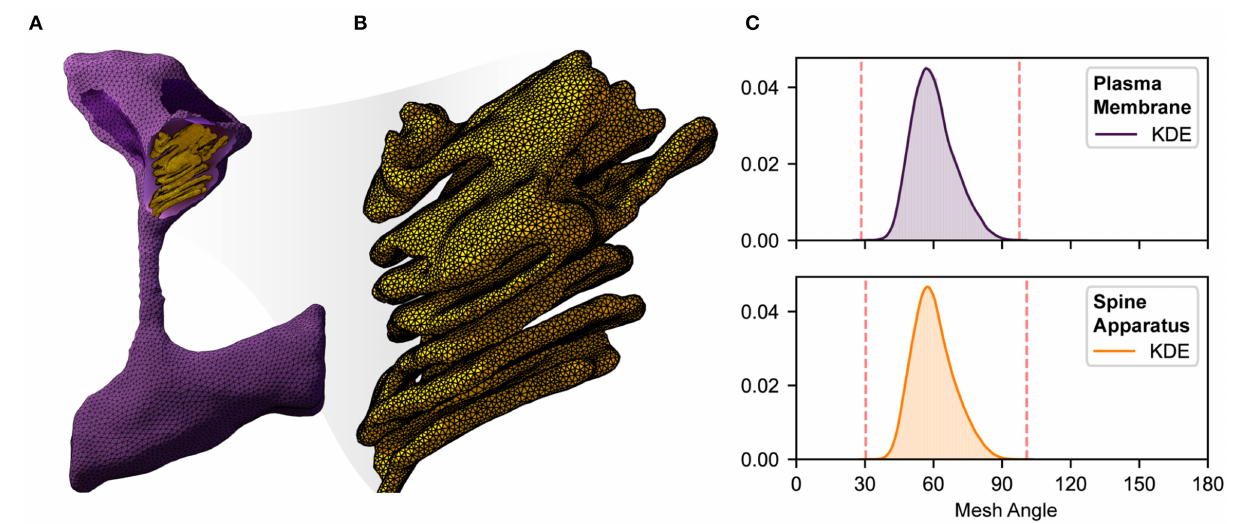
FIGURE 2 | An illustration of complexity, size, quality, and local resolution of meshes typically needed for realistic simulation of biophysical systems. Meshes are generated using GAMer 2 [11, 107]. (A) Example surface mesh of a dendritic spine with geometry informed by electron micrographs from Wu et al. [24]. The plasma membrane is shown in purple with the post synaptic density rendered in dark purple. The spine apparatus, a specialized form of the endoplasmic reticulum is shown in yellow. (B) A zoomed in view of the spine apparatus. Note that the mesh density is much higher in order to represent the fine structural details. (C) Binned histogram distributions of mesh angles for both the plasma membrane and spine apparatus. The colored smooth lines are the result of a kernel density estimate. Dotted red lines correspond to the minimum and maximum angle values in each mesh. Both meshes are high quality with few high aspect ratio triangles (i.e., those deviating most from